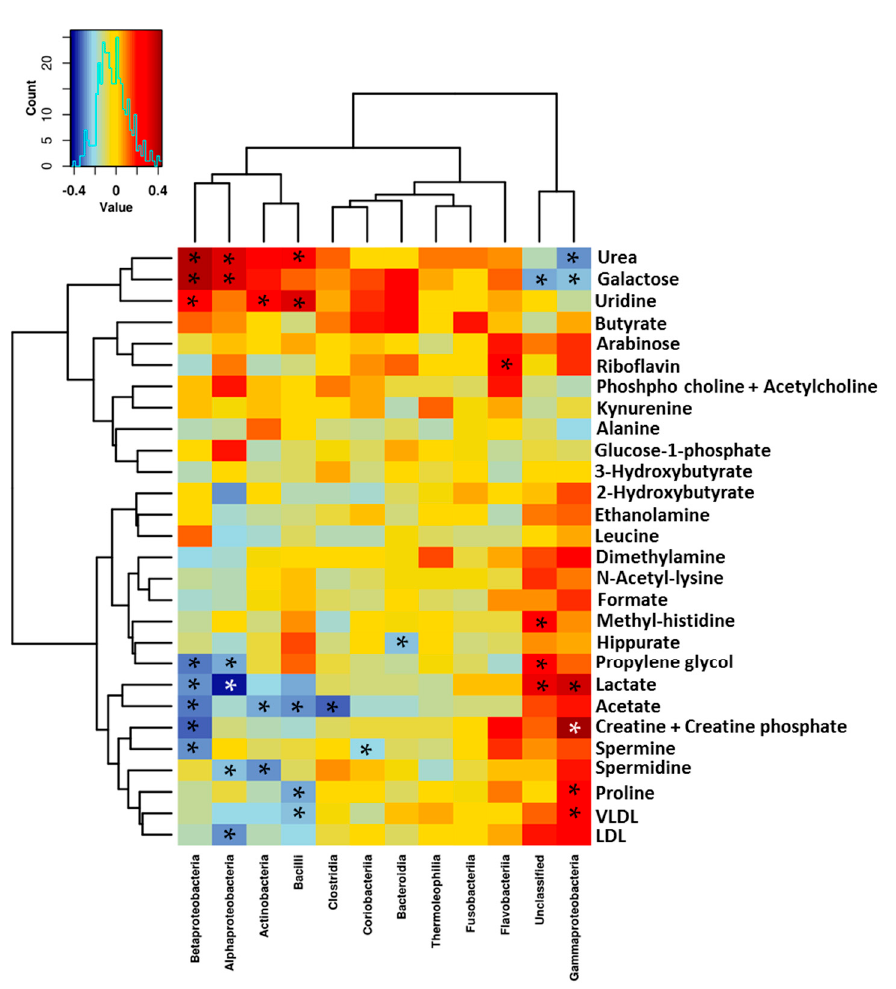
Figure 8. Heat map to show Spearman’s correlation between metabolites and microbiota composition at class level. Asterisk indicates statistically significant correlation at the level of ( p < 0.05). LDL and VLDL should be considered LDL- and VLDL-like particles with similar nuclear magnetic resonances (NMR), structure and mobility than plasma LDL and VLDL.